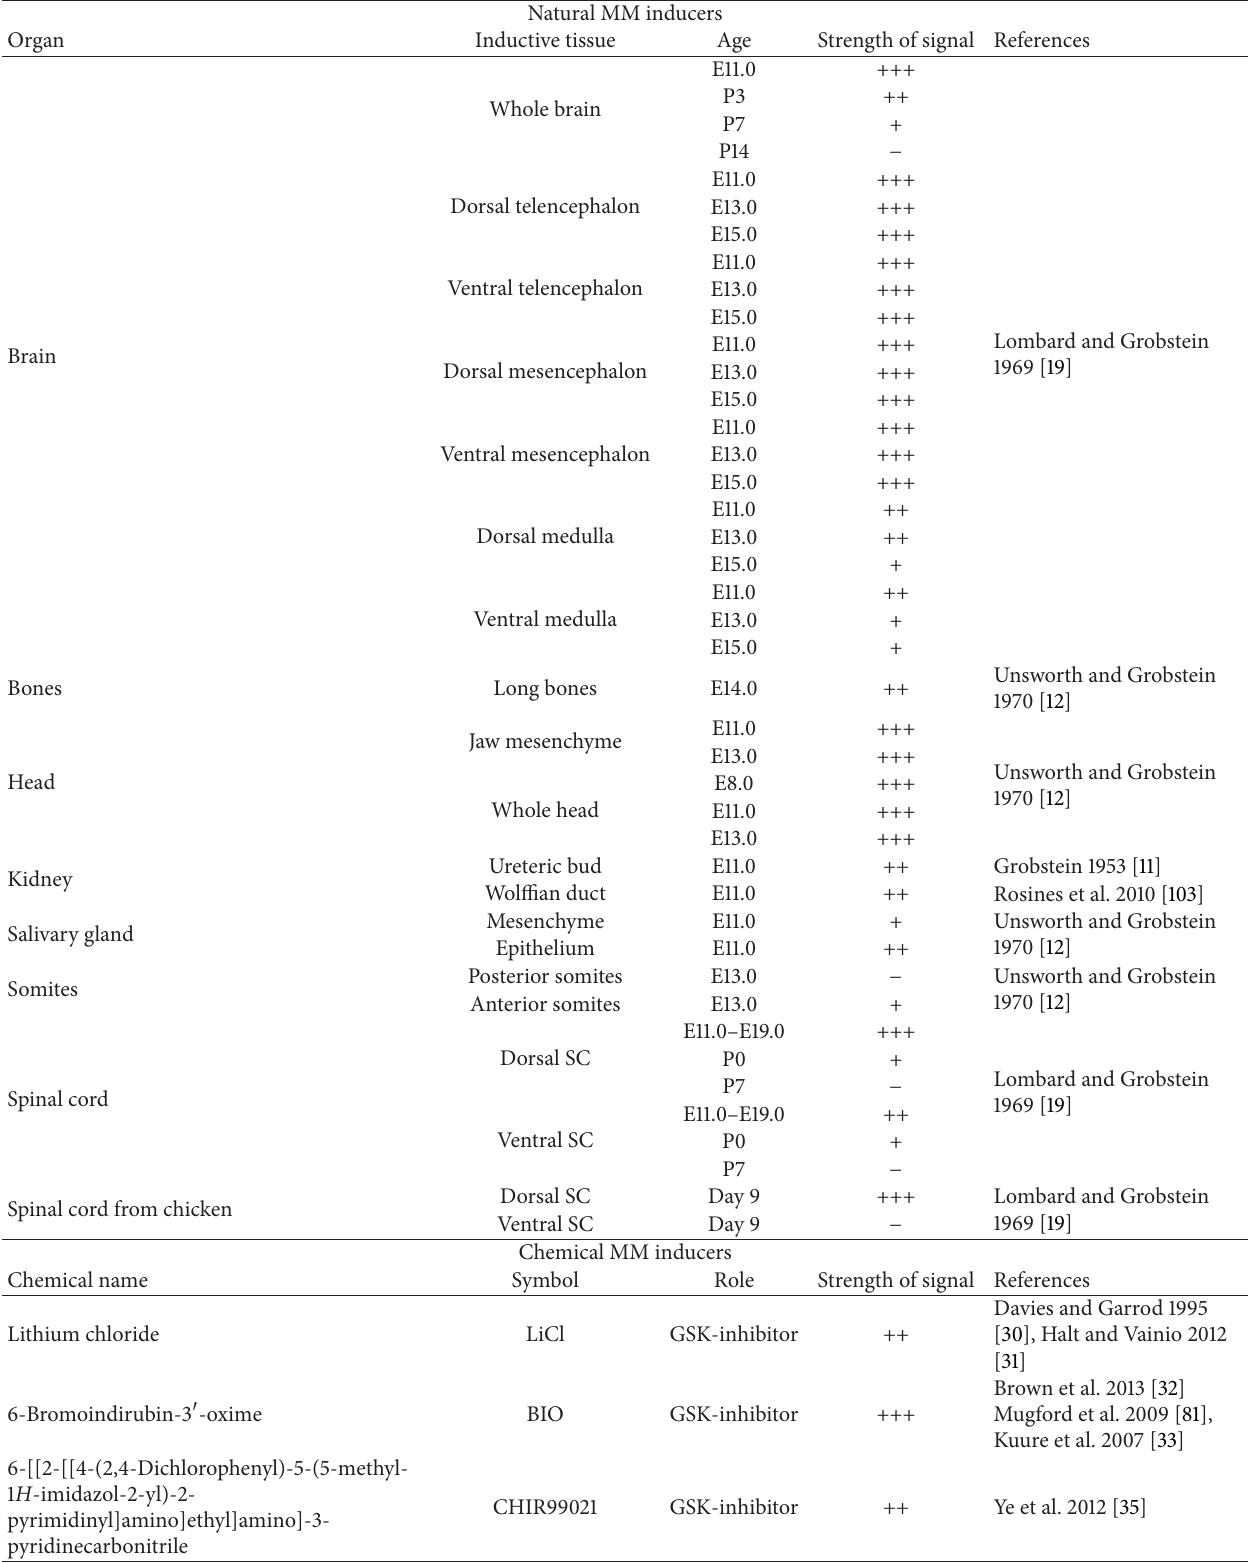
Table 1: Natural and chemical MM